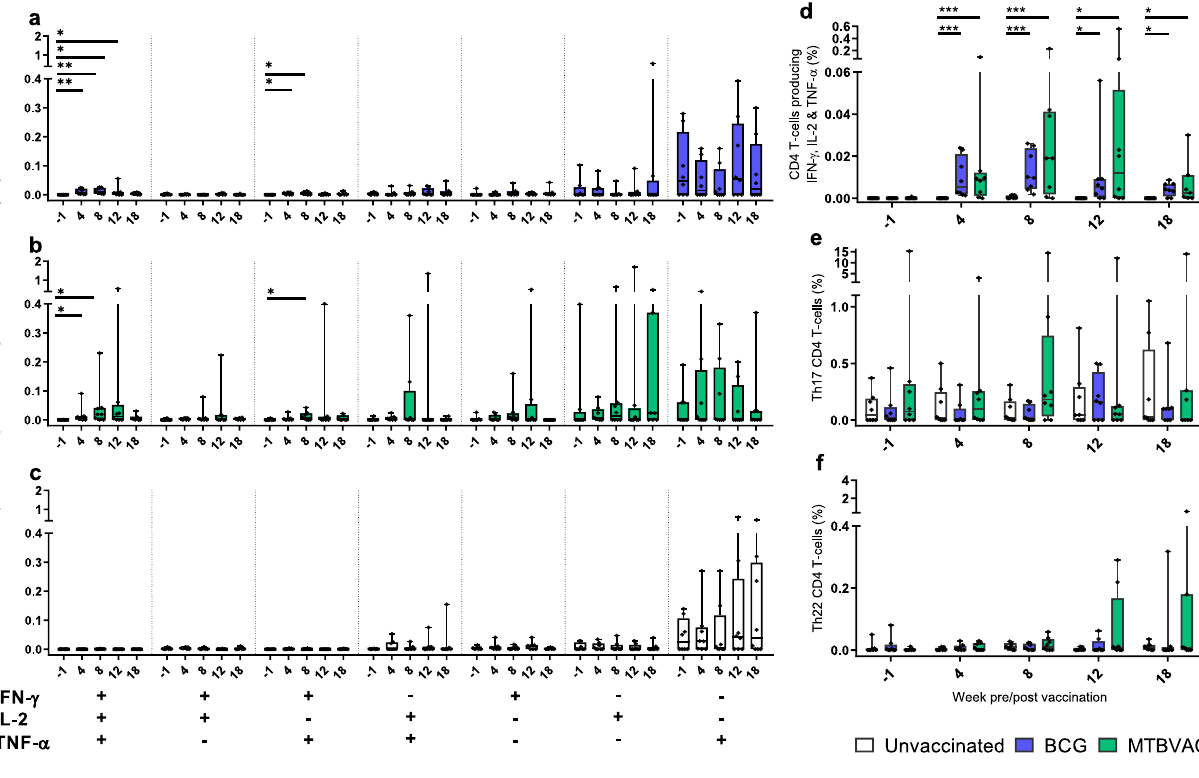
Fig. 4 M. tuberculosis peptide-speci fi c CD4 T-cell cytokine secretion pro fi les measured by whole blood intracellular cytokine staining. Box plots show the vaccination group median frequency of CD4 T-cells producing combinations of the cytokines IFN- γ , IL-2 and TNF- α ( a – d ); IL-17 ( e ) or IL-22 ( f ) + / − IQR with minimum and maximum values indicated by box whiskers. Cytokine production was measured at weeks prior to ( − 1), and following (4, 8, 12 and 18) BCG or MTBVAC vaccination. Signi fi cant differences between pre- and post-vaccination values (Wilcoxon signed-rank) and between groups (Mann – Whitney U test) are indicated by bars and asterisks: * P ≤ 0.05, ** P ≤ 0.01, *** P ≤ 0.001 (all P values are unadjusted for multiple comparisons). Frequencies measured in individual animals are represented by